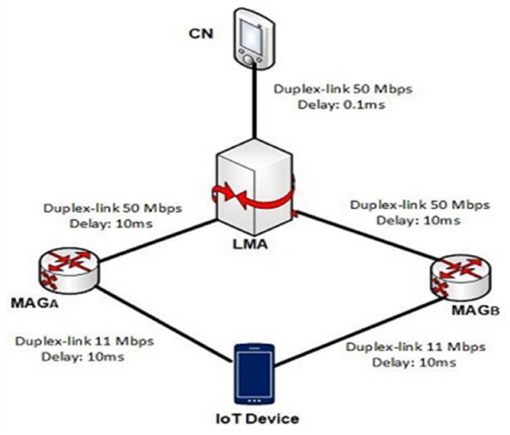
Figure 4. Simulation network